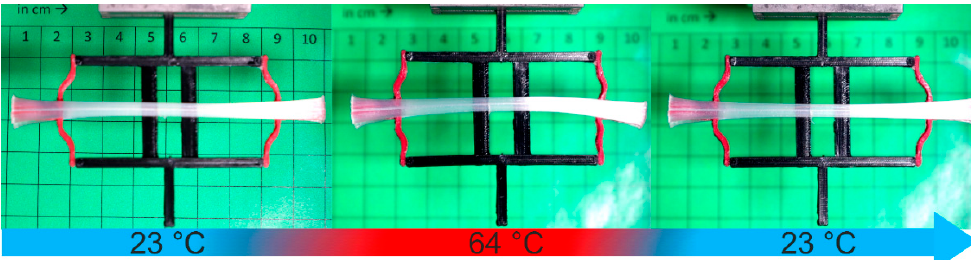
Figure 12. Thermoresponsiveness of a unit cell with a PEU actuator element. Centimeter paper was used as a base.